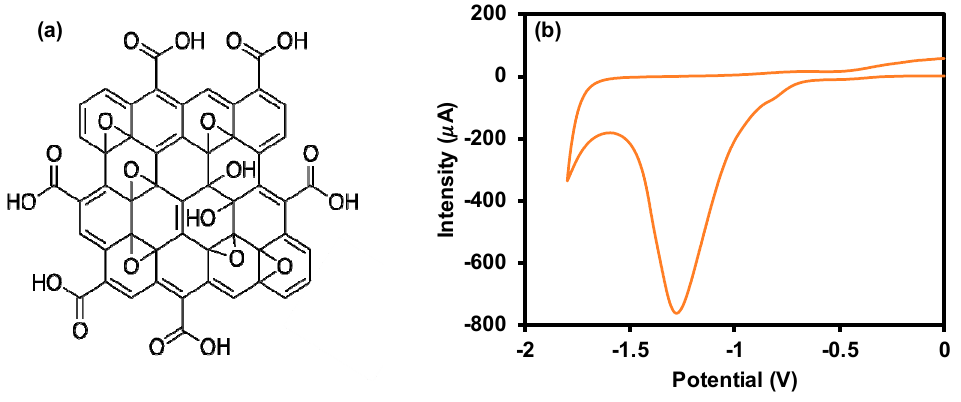
Figure 1. Graphene oxide nanocolloid (GONC) structure (a) and electrochemical reduction peak (b). Conditions: scan rate 50 mV; 0.1 M PBS, pH